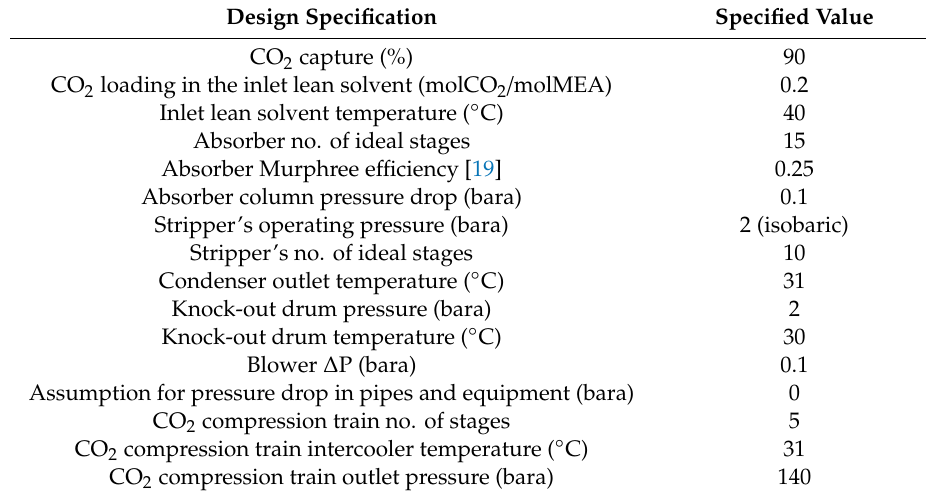
Figure 1. Post combustion CO 2 capture process flow sheet. Table 1. The operating conditions of the main units in the simulated flowsheet.